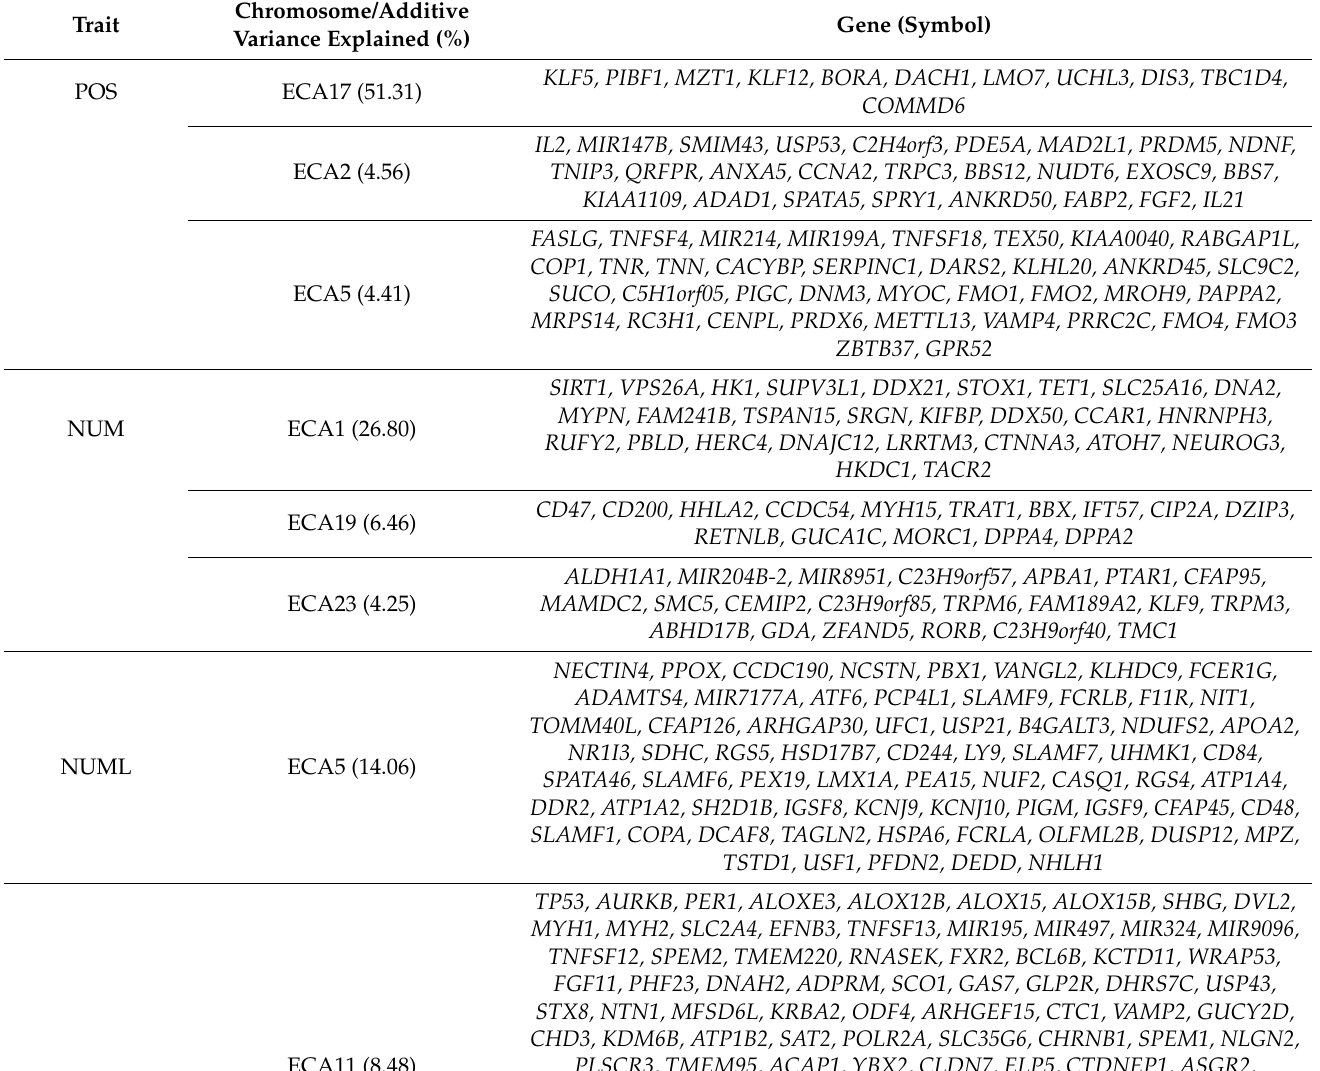
Table 3. Genes within significant windows for each